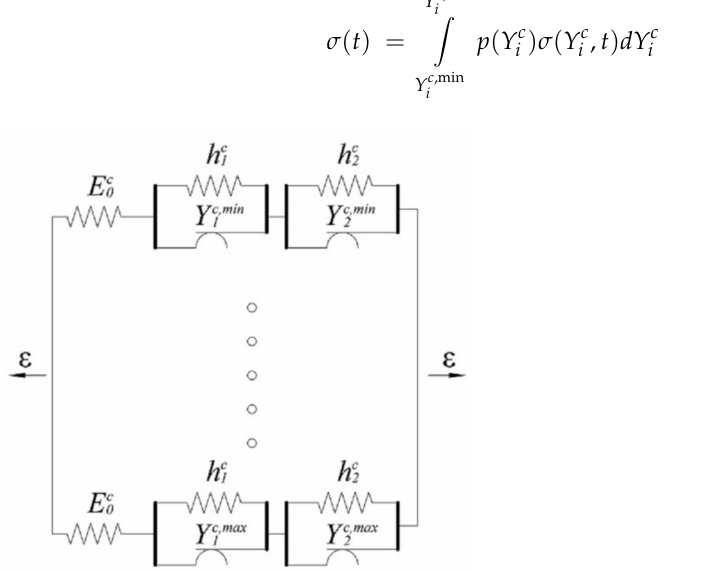
Figure 5. Model of polycrystalline material: parallel connection of an infinite number of single elements with yield limits Y ic,min ≤ Y i ≤ Y ic,max